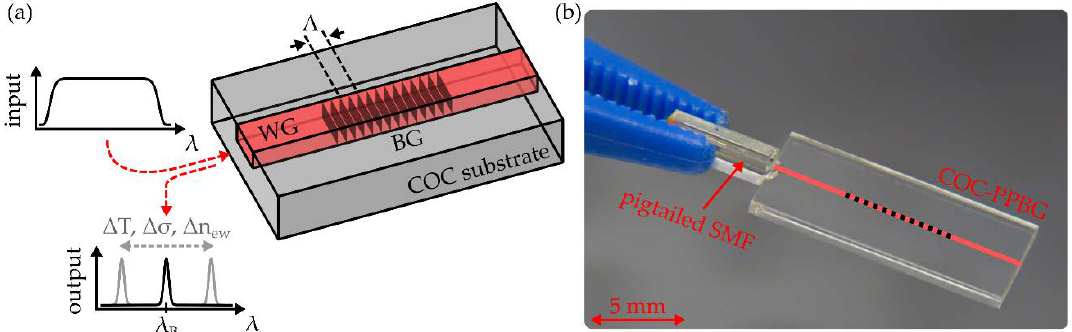
Figure 1. ( a ) Working principle of a polymer planar Bragg grating (PPBG) comprising a buried waveguide (WG) as well as a Bragg grating (BG); ( b ) PPBG based on a cyclic olefin copolymer (COC) substrate. For evaluation purposes, the PPBG needs to be butt coupled to a pigtailed single-mode fiber